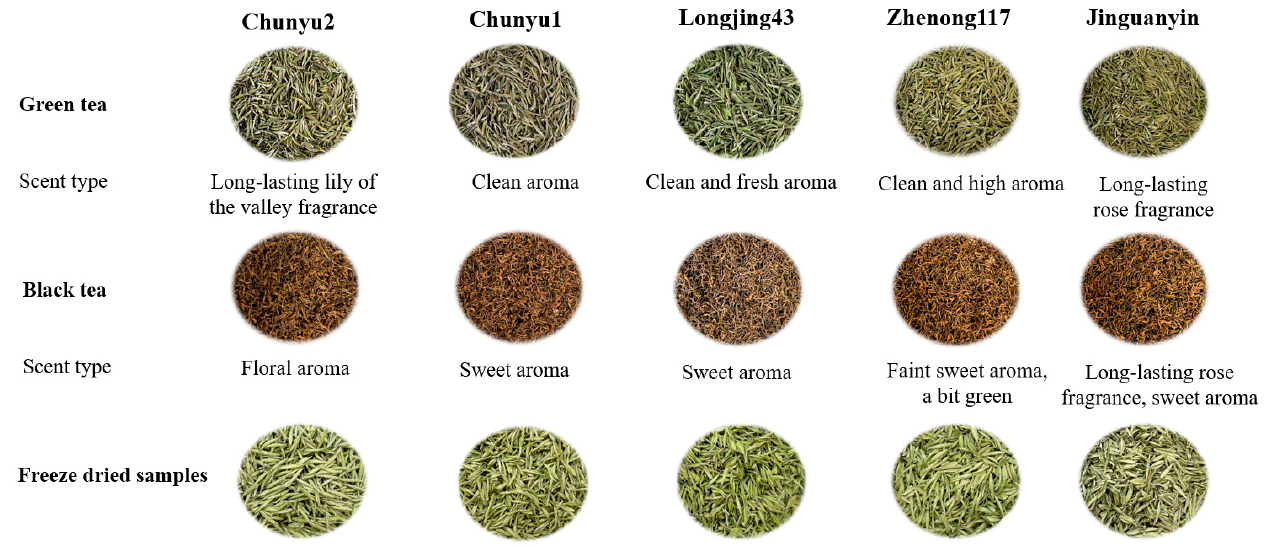
Figure 1. Pictures of freeze-dried samples, green, and black teas from different tea cultivars and their identified scent type. One-third of the harvested fresh tea leaves were freeze-dried immediately, while the remaining two-thirds were divided into two fractions for green and black tea preparation, respectively.